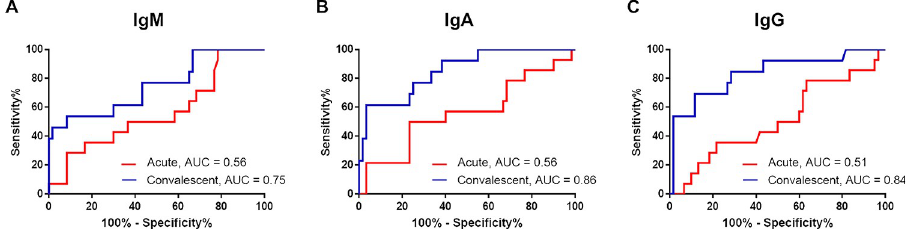
Fig 4. Receiver operating characteristics (ROC) curves of specific antibodies obtained from the acute and convalescent serum of COVID-19 patients. The area under the ROC curve (AUC) is shown for IgM (A), IgA (B) and IgG